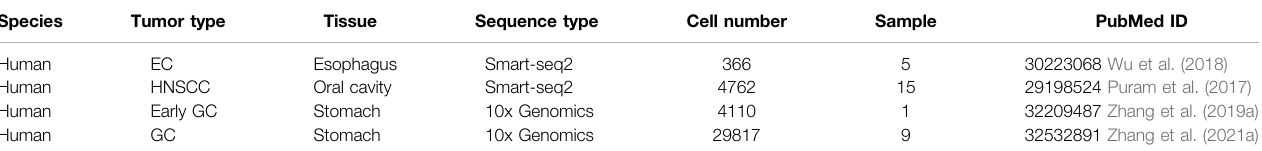
TABLE 1 | Single-cell RNA-seq data of UGIC.